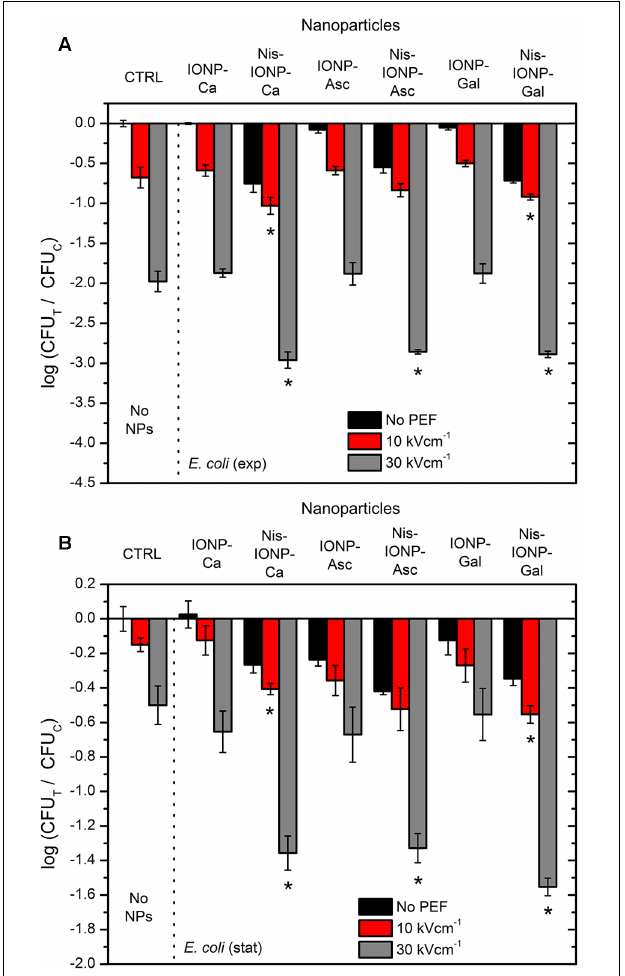
FIGURE 2 | Inactivation of Escherichia coli using different pulsed electric field (PEF) protocols and nanoparticles (NP), where (A) , exponential bacteria growth phase; (B) , stationary bacteria growth phase. CTRL, control samples without NPs; IONP, iron oxide nanoparticles; Nis, nisin-loaded. Different capping agents were used such as citric (Ca), ascorbic (Asc), and gallic (Gal) acids. The number of residual culturable cells in the samples after the PEF treatment (CFU T ) was compared with ones in the control samples without treatment (CFU C ). The asterisk ( ∗ ) represents statistically significant ( P < 0.05) difference versus untreated